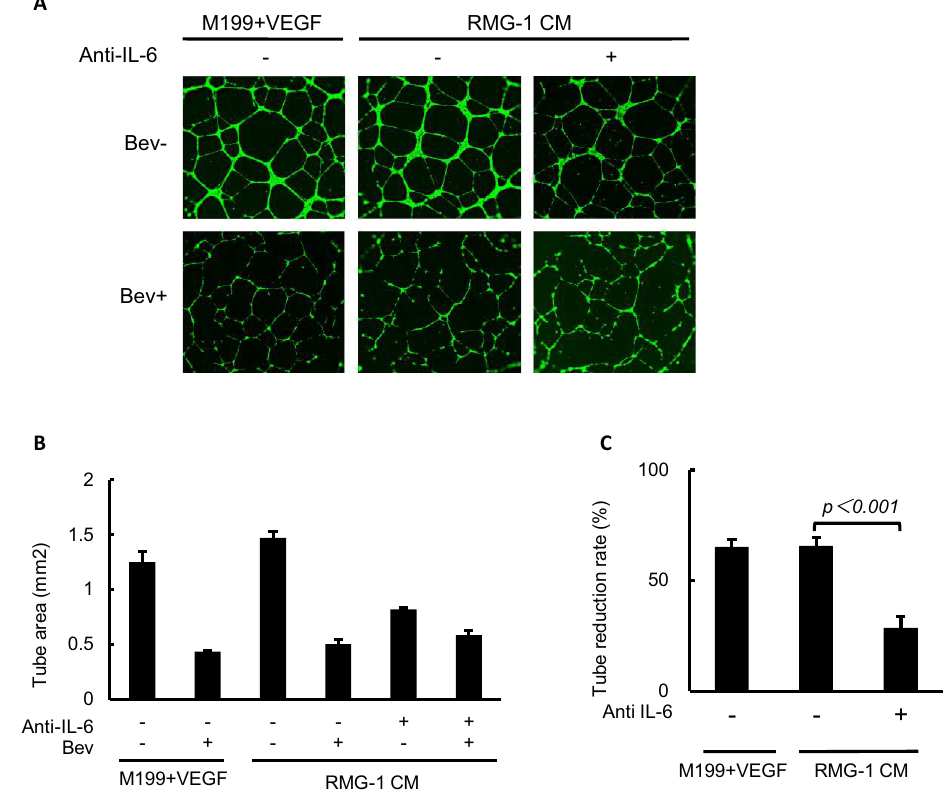
Figure 1. Attenuation of the anti-angiogenic function of Bev in culture media of IL-6 blocked OCCC cell. ( A ) Representative images of tube formation of HUVEC with the indicated culture media and reagents (magnification × 100). Fluorescent microscope observation was made after 18 h of incubation and Calcein AM staining. ( B ) Tube areas in each well with indicated condition were measured by hybrid cell count software. Data were average of triplicated well. ( C ) The tube reduction rate by Bev treatment with or without IL-6 blockade. IL-6 blockade weakened Bev function. Data are shown from one of two independent experiments with similar results. Error bars are SEs. All the images were observed by fluorescence microscope (BZ-X800, Keyence, Osaka, JAPAN). Then, these obtained images were analyzed by the BZ-H4C analytic application (Keyence) for hybrid cell count and the BZ-H4CM application (Keyence) for macro cell